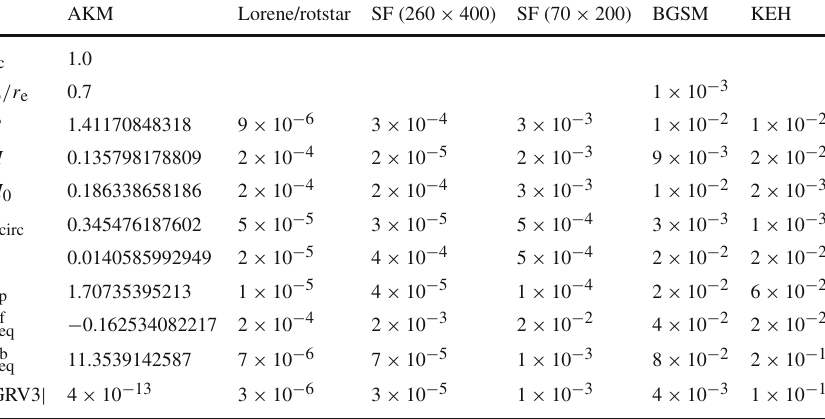
Table 2 Detailed comparison of the accuracy of different numerical codes in computing a rapidly rotating, uniform density model AKM Lorene/rotstar SF (260 × 400) SF (70 × 200)